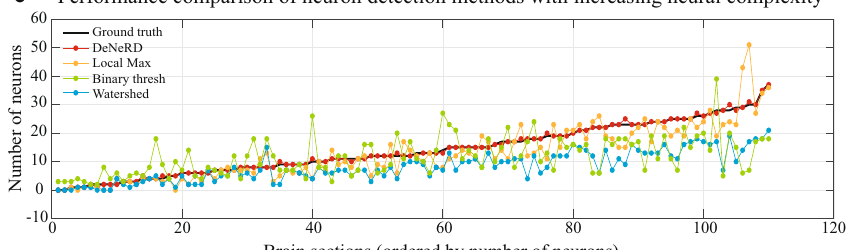
Figure 7. Quantitative performance of DeNeRD in neuron detection in comparison with other methods. ( a ) Precision-Recall curve of our method on the testing dataset. The deep neural network achieves a high score in detecting neurons with a mean average-precision (mAP) of 0.9. ( b ) Performance comparison of DeNeRD with commonly used neuron counting methods. DeNeRD gives the minimum offset (error between the ground- truth and prediction) on the testing dataset. The horizontal bar indicates the mean error on the complete testing dataset and each data point represents the error for a single brain section (n = 110). ( c ) DeNeRD performs well with an increase in complexity of neural structures and population density, whereas other methods drop off their performance. Brain sections are ranked according to their neural densities in the x-axis whereas the y-axis labels the number of neurons in the corresponding brain